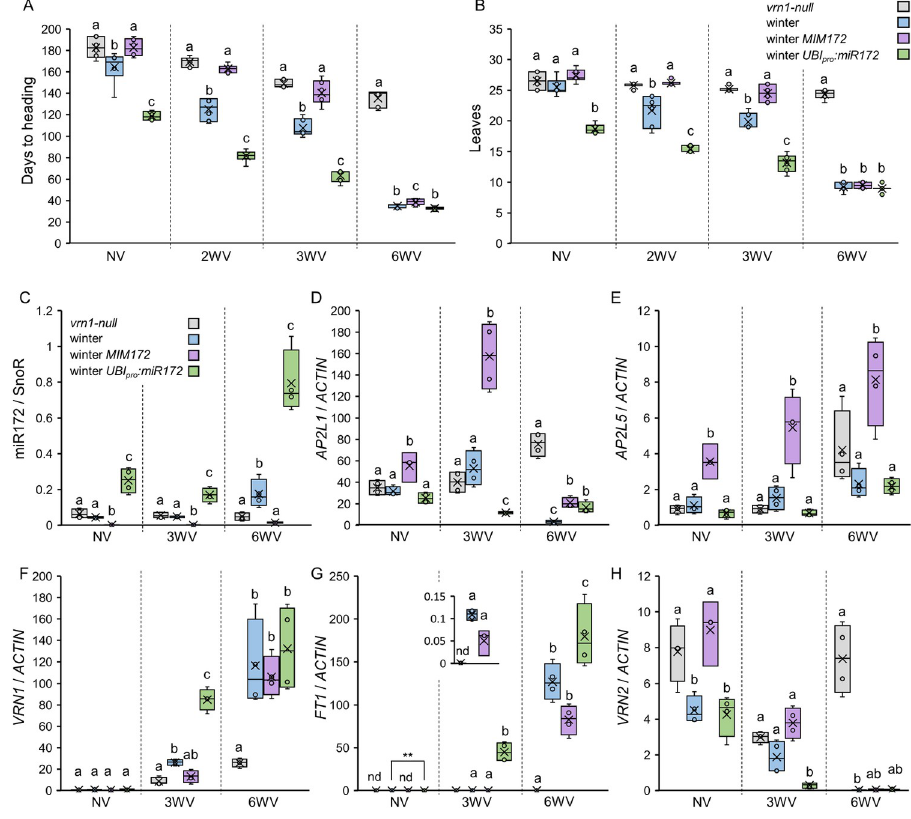
Fig 6. miR172 levels modulate the flowering response in winter wheat plants. ( A-B ) Box plots showing days to heading ( A ) or number of leaves in the main tiller ( B ) for vrn1 -null, winter Kronos, winter MIM172, and winter UBI pro : miR172 plants grown under LD conditions without vernalization (NV), with 2 (2WV), 3 (3WV) and 6 (6WV) weeks of vernalization (n � 6). ( C-H ) Expression levels of miR172 ( C ), AP2L1 ( D ), AP2L5 ( E ), VRN1 ( F ), FT1 ( G ) and VRN2 ( H ) determined by qRT-PCR in the 9 th leaf of vrn1 -null, winter Kronos, winter MIM172, and winter UBI pro : miR172 plants grown under LD conditions in the absence of a vernalization treatment, and after 3 (3WV) and 6 (6WV) weeks of vernalization. After vernalization, the plants were moved to room temperature for 25 days before the fully expanded 9 th leaf was collected. SnoR was used as internal reference for miR172, and ACTIN was used as internal reference for the other genes. Data correspond to four independent biological replicates. Different letters above the box-plots indicate significant differences ( P < 0.05) in Tukey tests performed within each vernalization treatment, except for panel ( B ) 2WV where a non-parametric Kruskal-Wallis test was used (Data F in S1 Data).